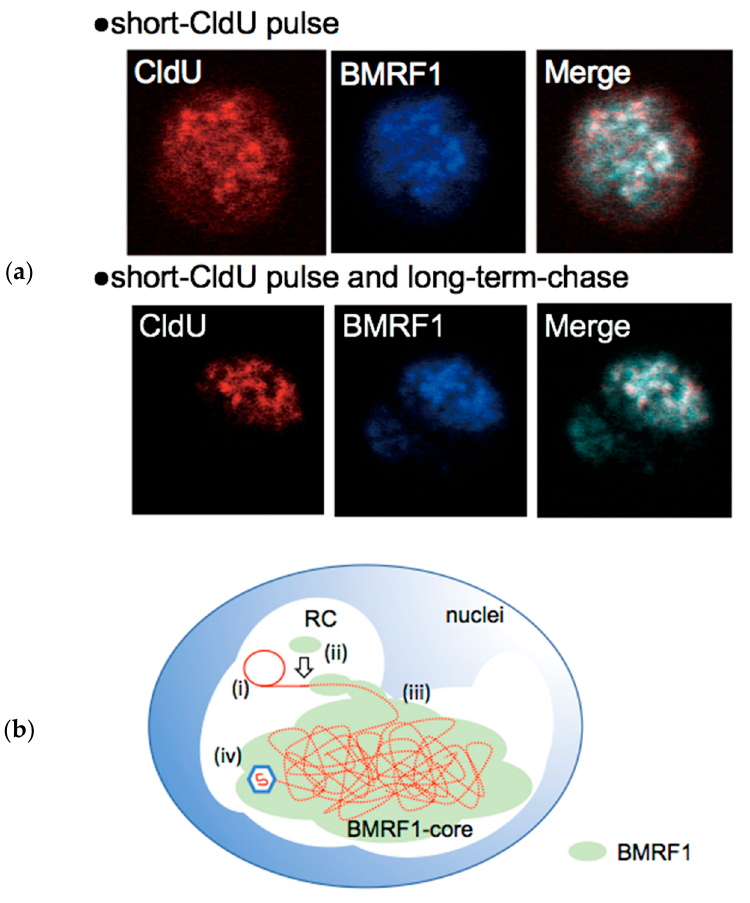
Figure 2. ( a ) Pulse-chase analysis revealing the existence of the RC subdomain, the BMRF1-core. The lytic phase was induced in Tet-Z/B95.8 cells by Dox treatment. At 24 h post-induction, the cells were treated with CldU for 10 min (short-CldU pulse). Then, cells were washed and incubated for 1 h to allow labelled DNA to move to DNA storage sites (short-CldU pulse and long-term chase). Approx- imately 40 cells were analyzed and images were captured. ( b ) Model of BMRF1-core formation. (i) The newly synthesized viral DNA mainly at the outside of the BMRF1-core in the RC. (ii) BMRF1 binds to synthesized viral DNA and folds to form the BMRF1-core that seems to be accumulated in the BMRF1-core. (iii) Viral DNA is stored until packed into the viral capsid. (iv) Finally, viral DNA is packed into the self-assembled